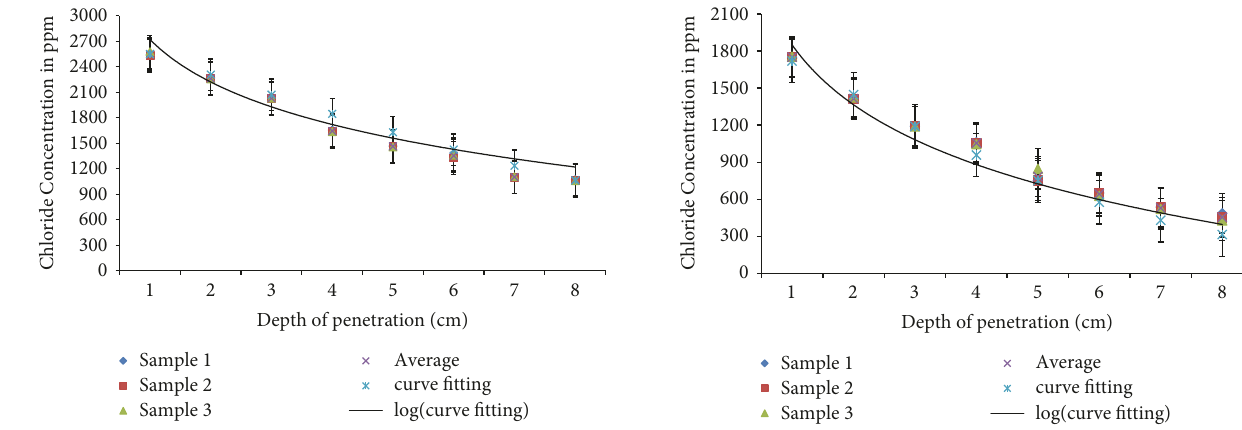
Figure 7: Error function fitting curve for PCC35-H 2 O.